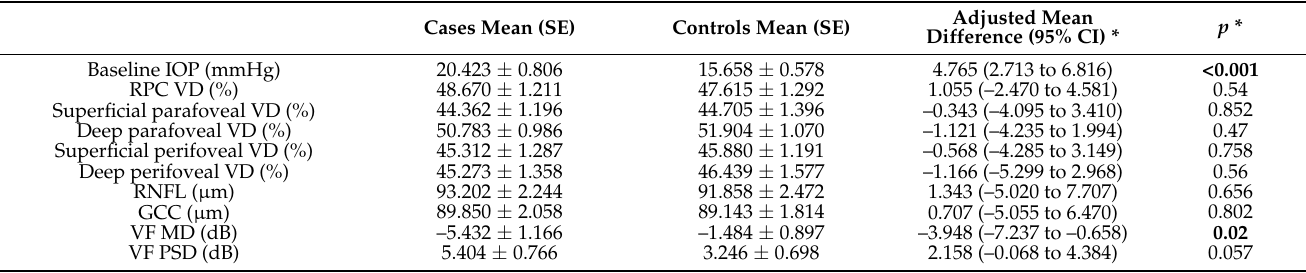
Table 1. Comparison of the baseline parameters between cases and